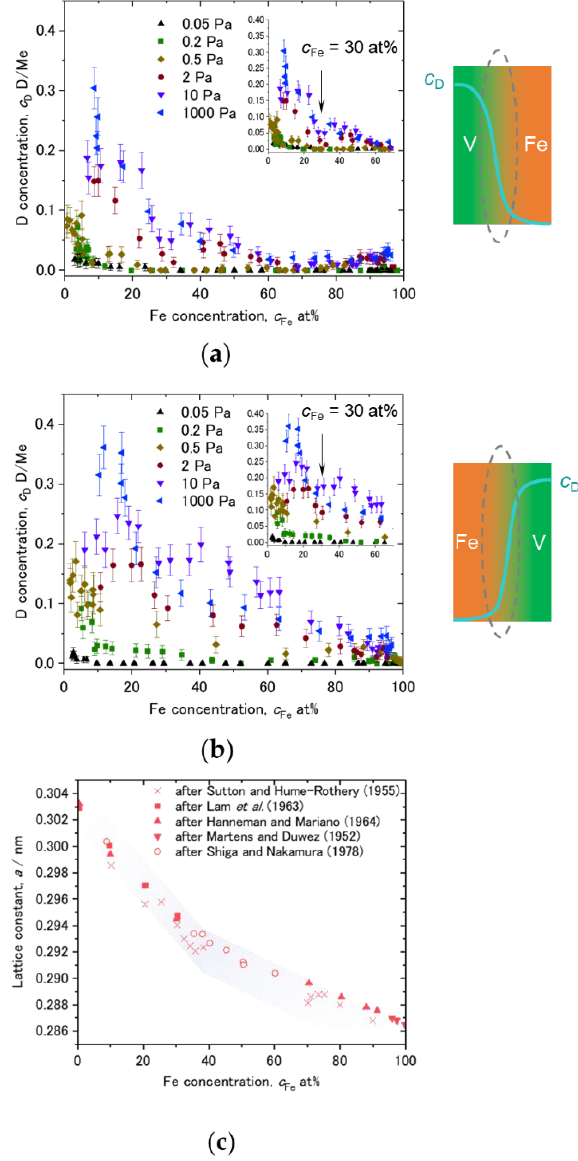
Figure 14. Dependence of c D on c Fe at various D 2 loading pressures, plotted for ( a ) V/Fe interface and ( b ) Fe/V interface at the 2nd V layer of Figures 8–12. Schematic drawings of c D change with c Fe at the intermixed regions are depicted next to the profiles. c Fe = 30 at% is marked by black arrows in the insets. ( c ) Change of lattice constant of FeV alloy against Fe concentration, reported by Shiga and Nakamura [46]. Individual data points were taken from Sutton and Hume-Rothery [47], Lam et al. [48], Hanneman and Mariano [49], Martens and Duwez [50], and Shiga and Nakamura [46]. Note the Vegard’s law slope changes at around c Fe = 30~35 at%.